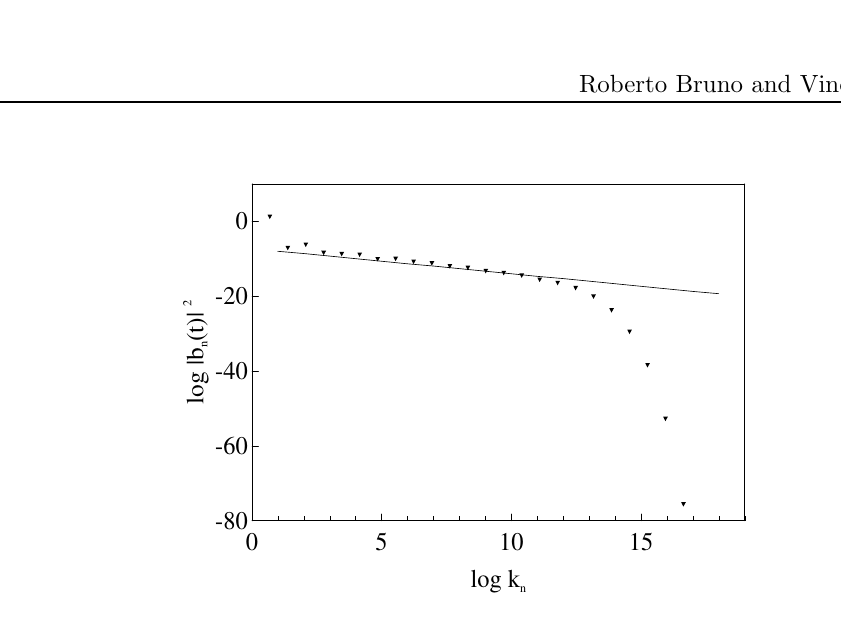
𝑘 𝑛 for the MHD shell 2